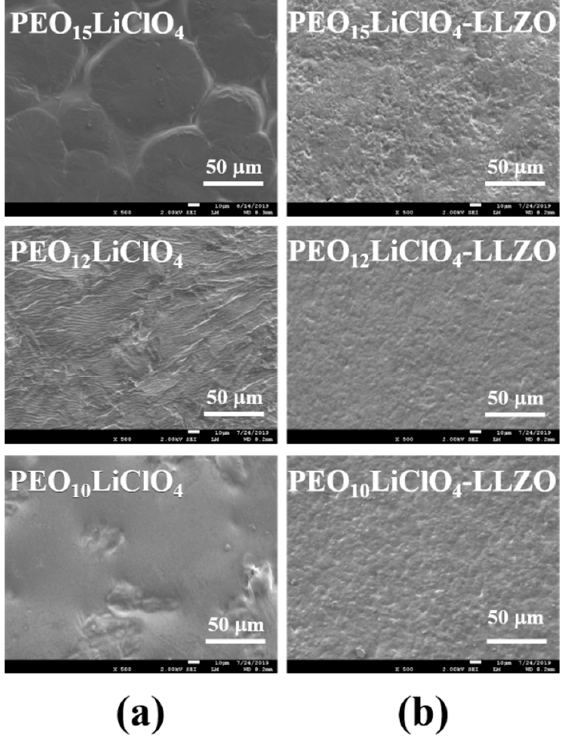
Figure 2. Scanning electron micrographs of ( a ) PEO n LiClO 4 and ( b ). PEO n LiClO 4 -LLZO films.